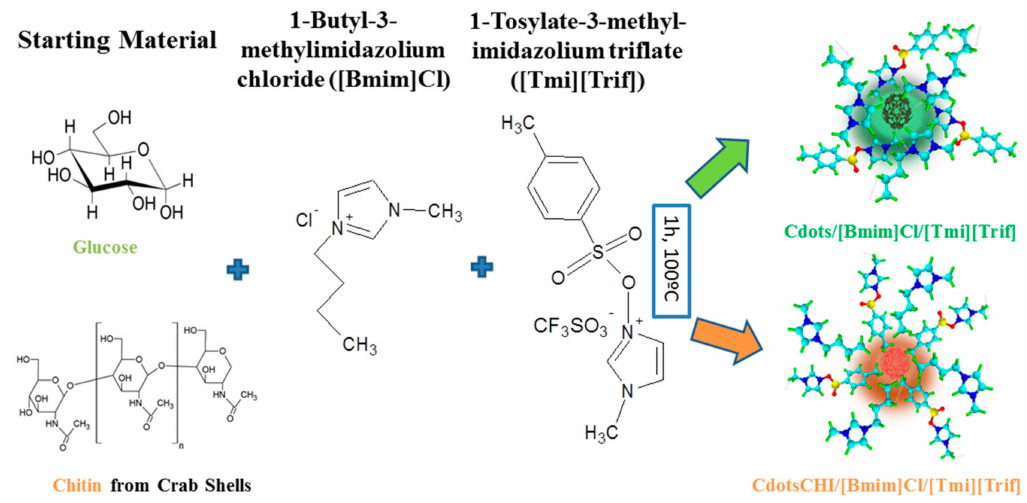
Figure 1. Schematic representation of the single-step synthesis of the Cdots / [Bmim]Cl / [Tmi][Trif] and CdotsCHI / [Bmim]Cl / [Tmi][Trif]